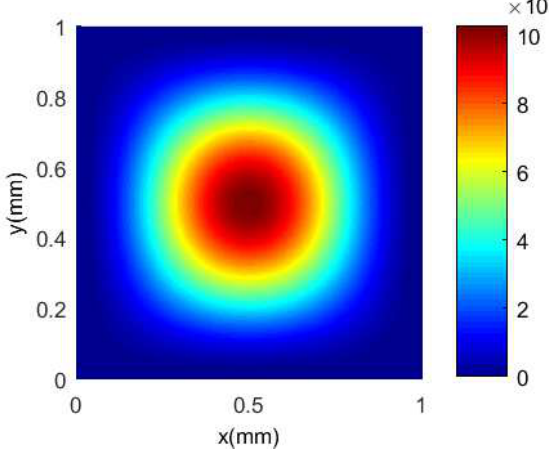
Figure 9. The Matlab nephogram of silicon cup deflection analytical solution.